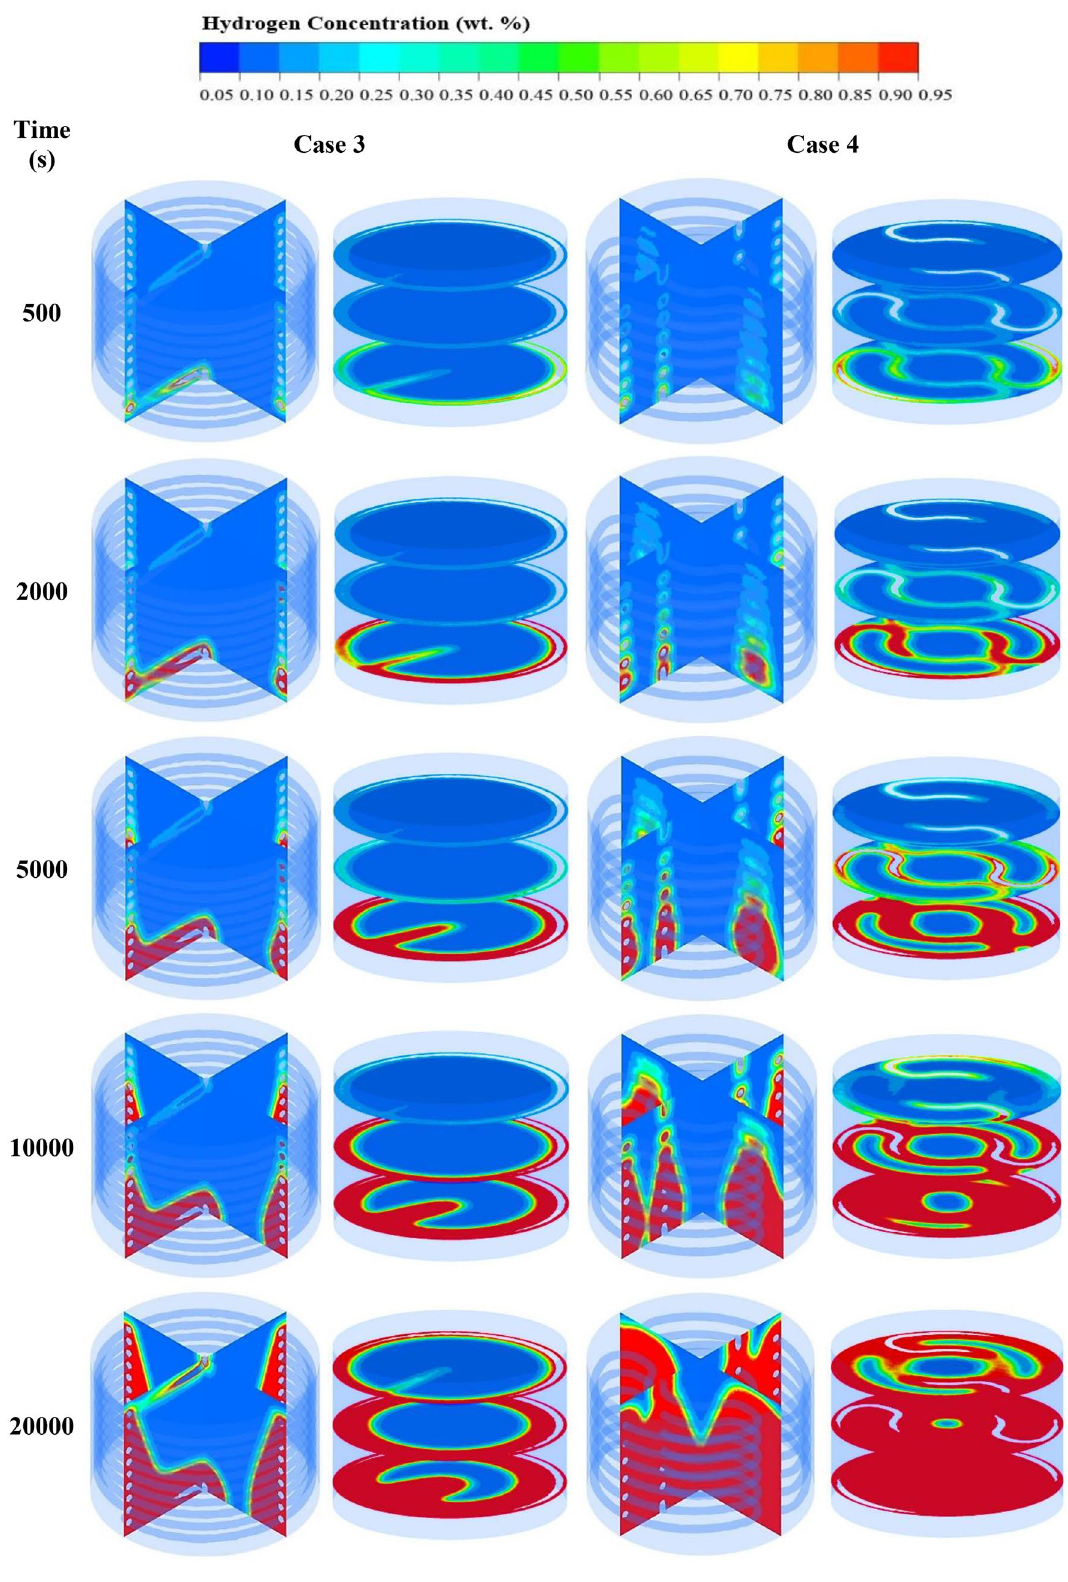
Figure 7. Comparison of hydrogen concentrations at 500 s, 2000s, 5000 s, 10,000 s, and 20,000 s after the start of the hydrogen absorption process between case 3 and case